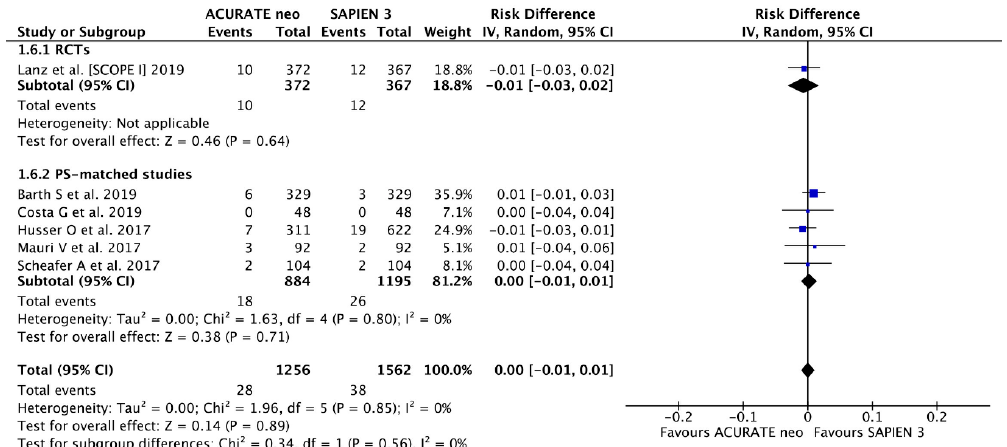
Figure A10. Clinical outcomes. Individual and summary risk ratios with corresponding 95% confidence intervals for the comparison of ACURATE neo and SAPIEN 3 in the analysis of stroke taking into account “0 events”.